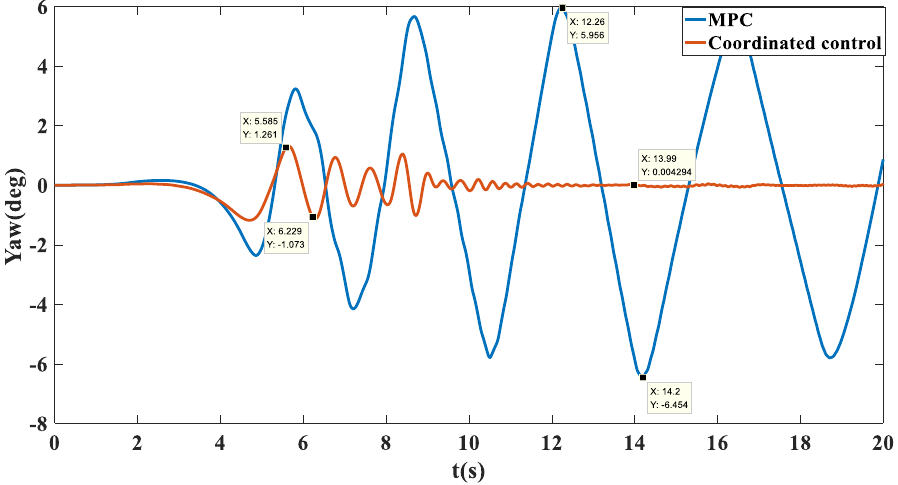
Figure 18. Speed tracking comparison chart on the sine sweep straight road.